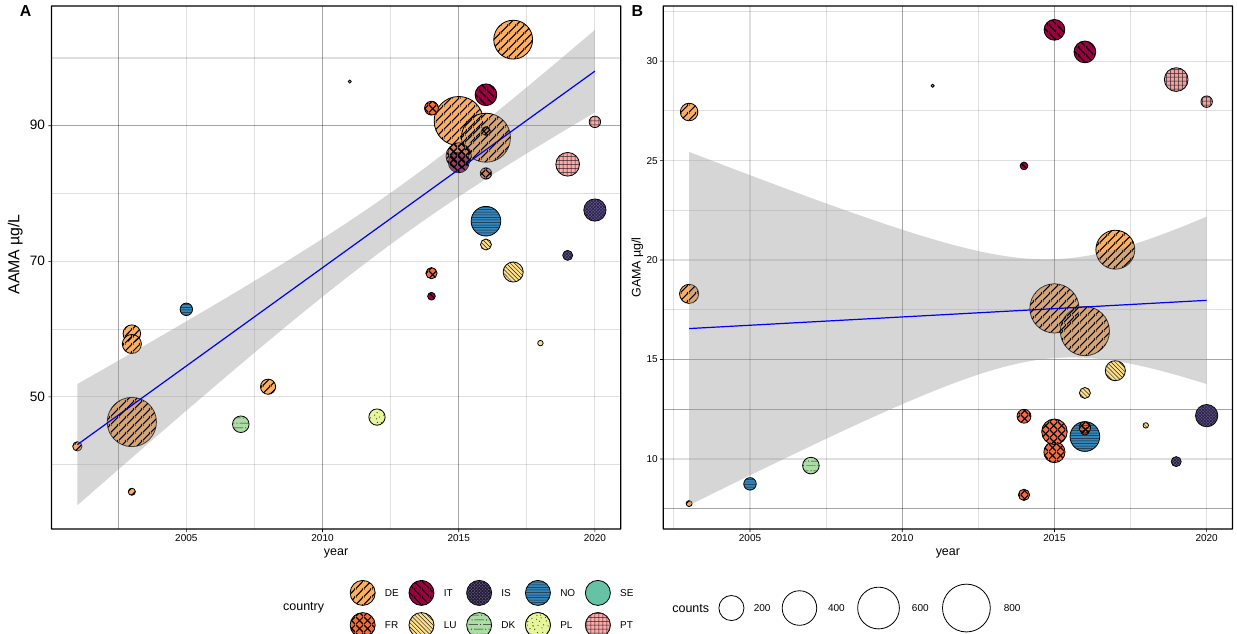
Figure 4. Linear model (regression) of harmonized means of acrylamide biomarkers AAMA and GAMA (non-smokers) as reported by European published papers and HBM4EU Aligned Studies (AAMA 30 studies, GAMA 29 studies). Regional distribution is indicated by colors and relative population size is shown by the size of the circles indicating single surveys. ( A ): AAMA in µg/L, ( B ): GAMA in µg/L. Gray: 95%-confidence interval. Regression line in blue. Multiple weighted regression adding mean population age as a variable showed a significant increase (estimate: +2.09 µg/L per year, p < 0.0001) for AAMA and a slightly negative trend for age (estimate: − 0.49 µg/L per year, p < 0.001). Differences in sex distribution (% of male samples) in study populations were used as another